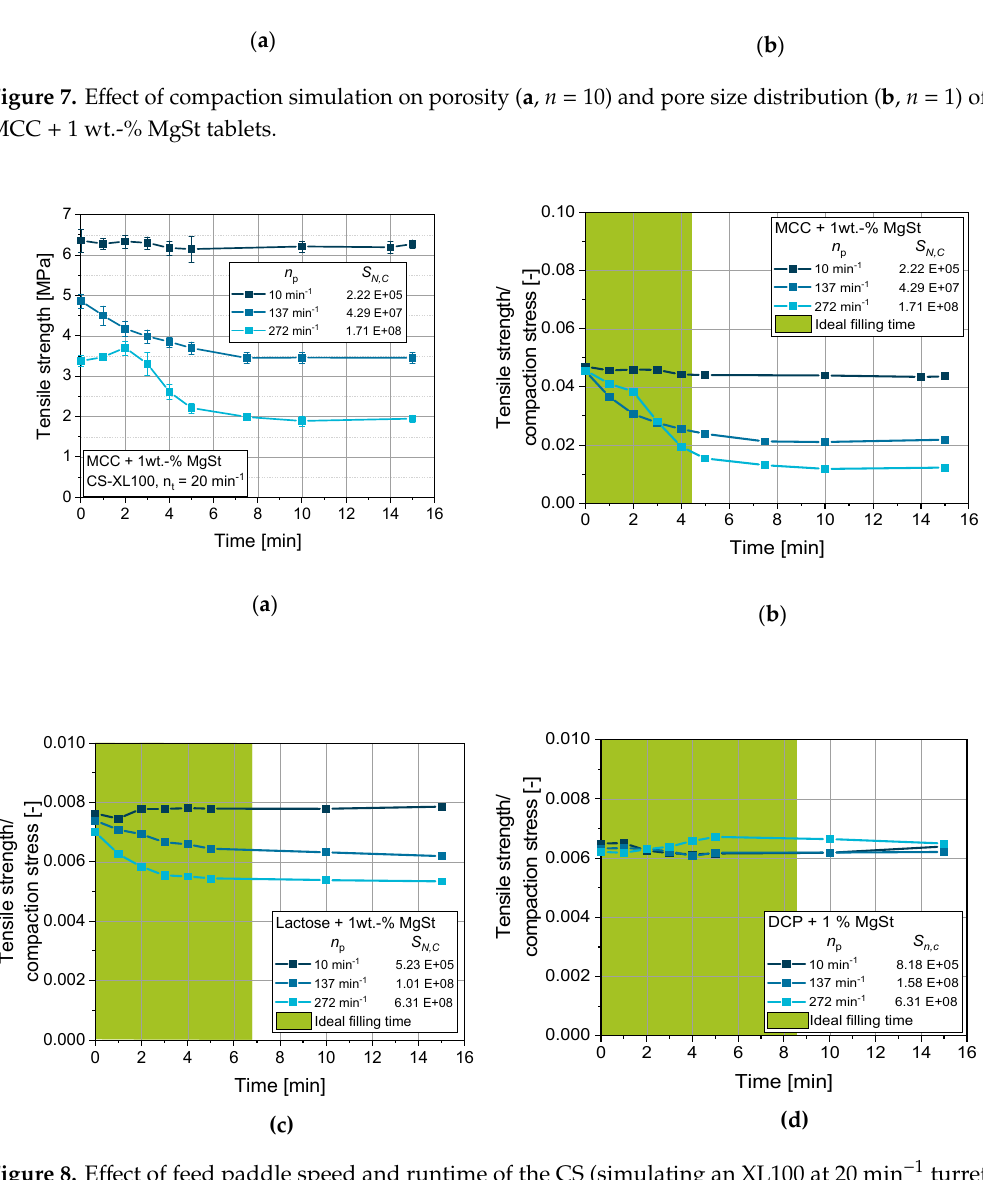
Figure 8. Effect of feed paddle speed and runtime of the CS (simulating an XL100 at 20 min − 1 turret speed) on the tensile strength of lubricated (1 wt.-% MgSt) excipients: not normalized for MCC ( a ) and normalized to compaction stress for MCC ( b ), lactose ( c ), and DCP ( d ), applying 14 mm punches, respectively. n = 10 .